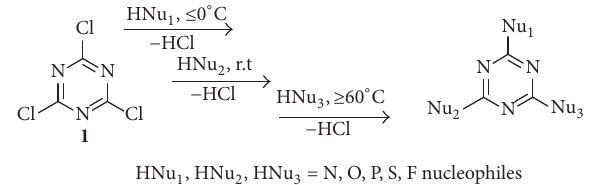
Scheme 1: Nucleophilic substitution reaction of cyanuric